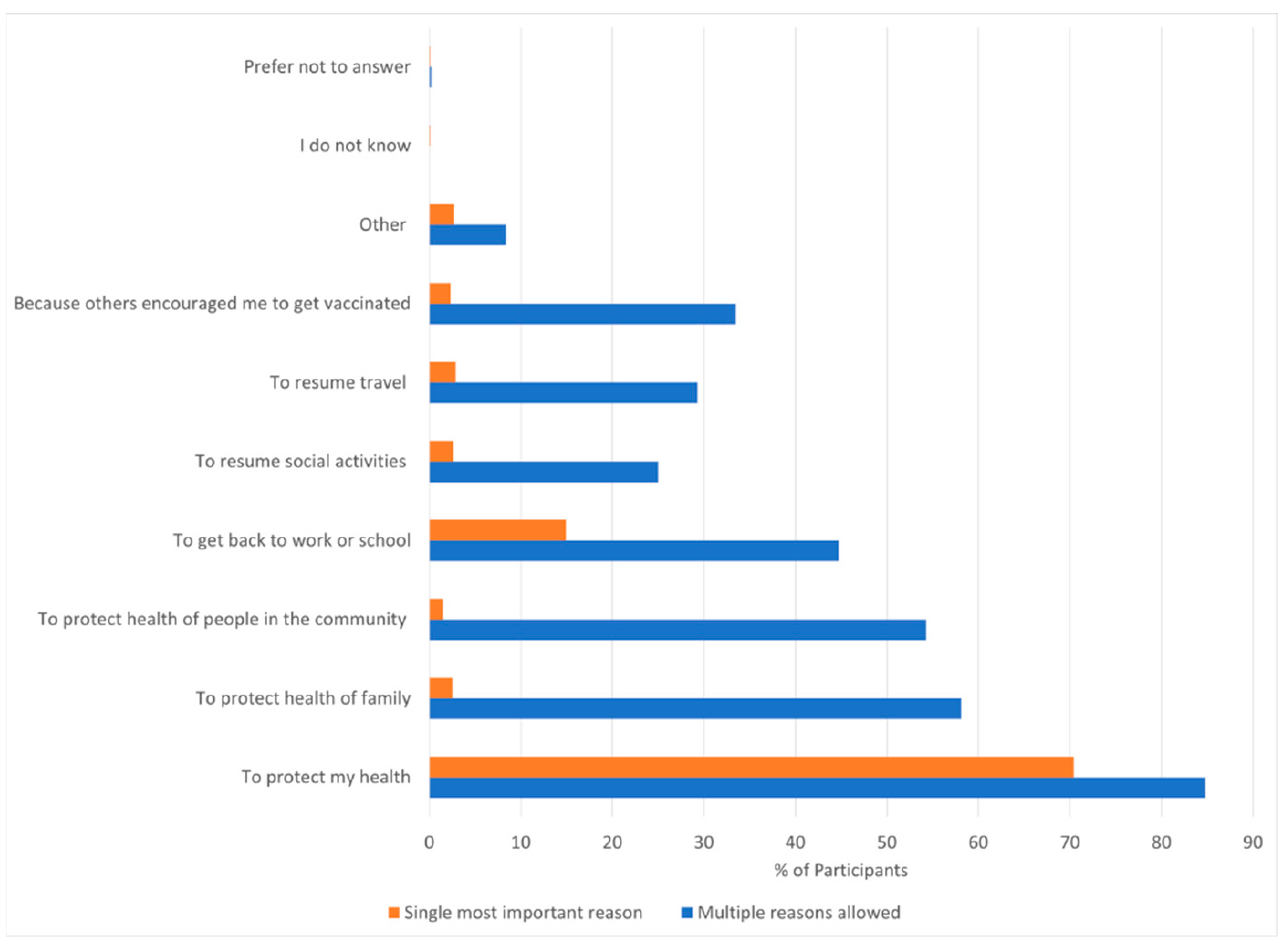
Figure 1. Reasons for presenting for vaccination today among late adopters of vaccination. Partici- pants were asked “Why did you get vaccinated today?”. Multiple responses were allowed